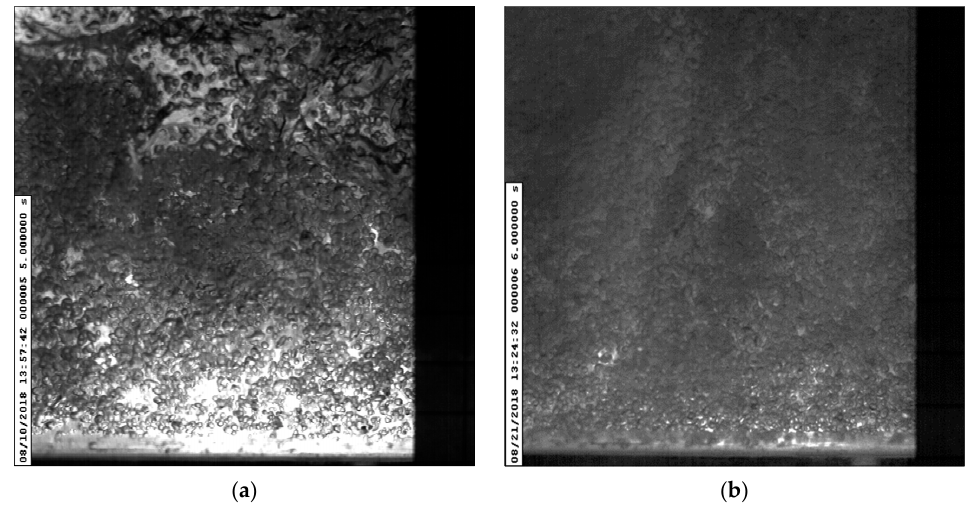
Figure 12. Lateral view of different scenarios in the measurement section: ( a ) Scenario with Q w = 0.4 m 3 /s/m and Q a = 0 L /s; ( b ) Scenario with Q w = 0.6 m 3 /s/m and Q a = 2500 L/s.